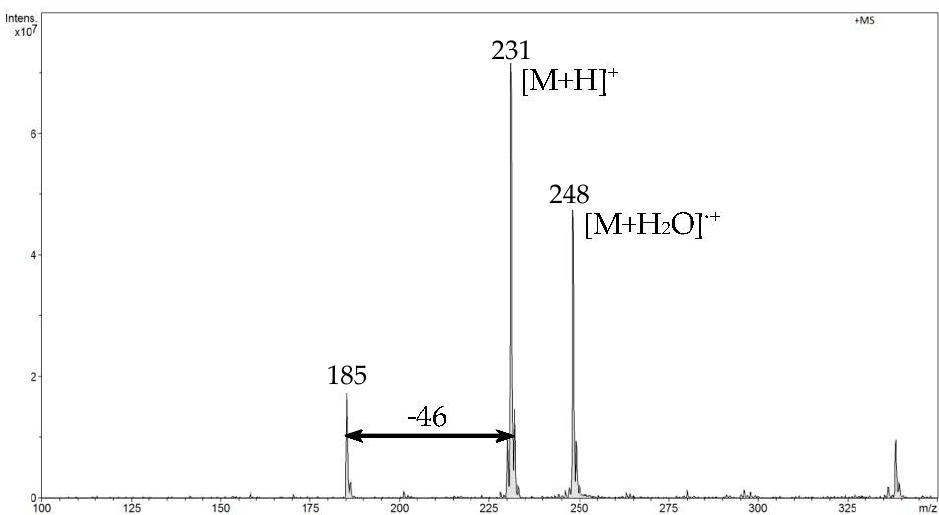
Figure 5. The FAPA ‐ MS spectrum of ibuprofen.